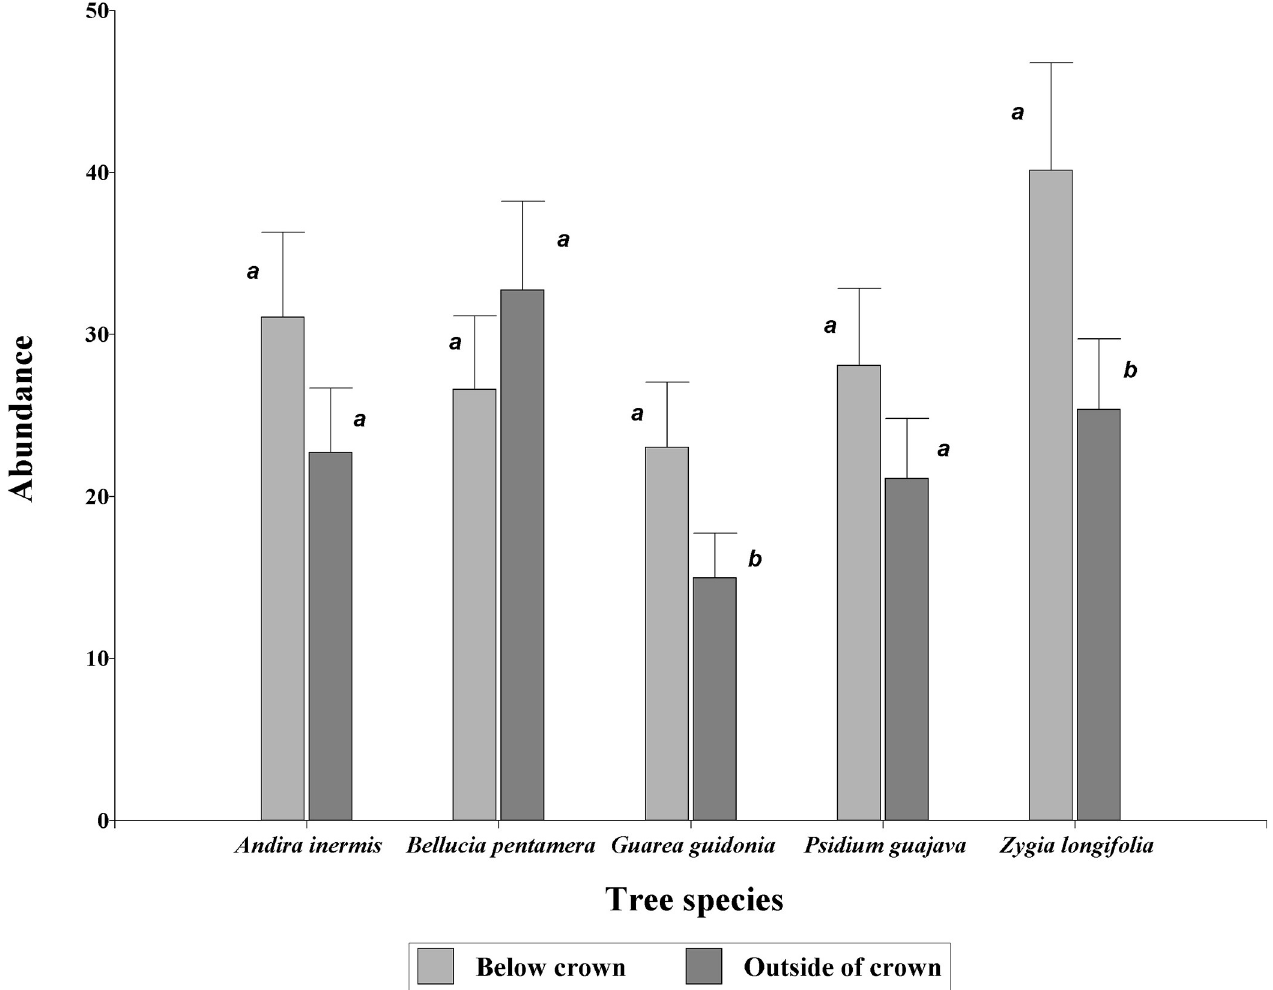
Fig 1. Abundance of macroinvertebrates below and outside the crown of tree species in grazing areas of pastures in the Colombian Amazonian piedmont. Equal letters within a species indicate equal means (P > 0.05).